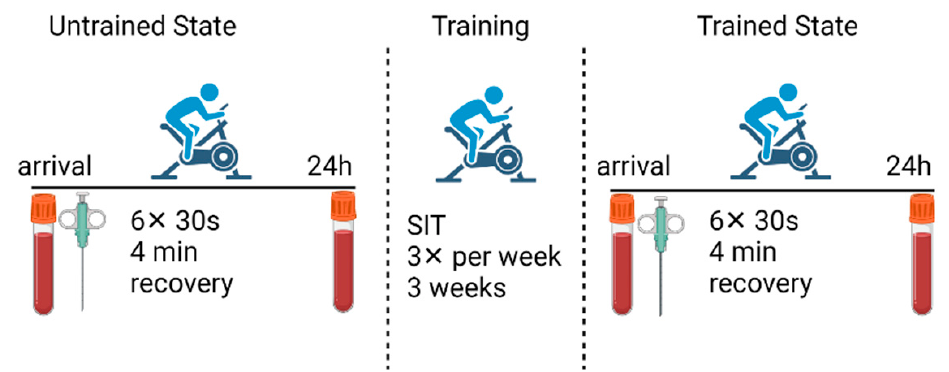
Figure 1. Schematic overview of the study outline. Volunteers undertook the first sprint interval training (SIT) session (untrained state) followed by three weeks of SIT training. The final training session (trained state) identical measures were taken. Tubes and needle indicate taking blood samples and muscle biopsies, respectively.